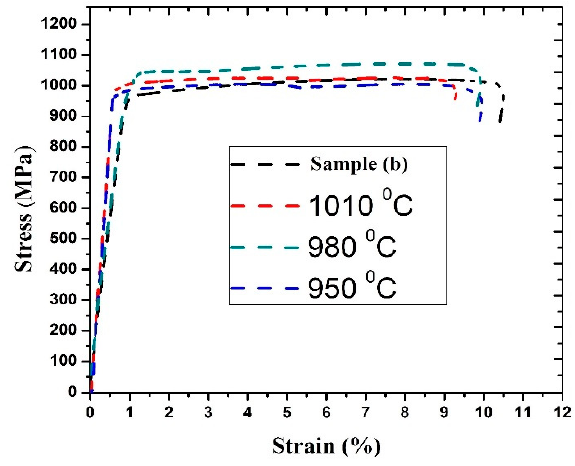
Figure 12. Stress strain curve of joints annealed at different temperatures.